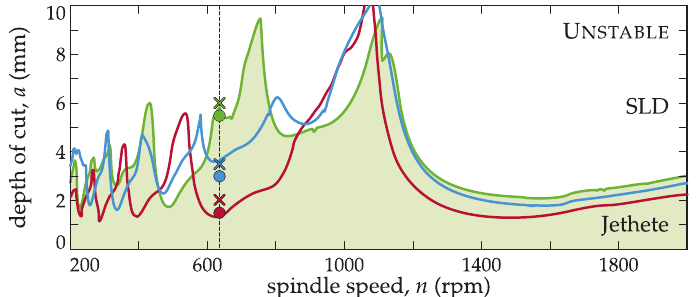
Figure 6. SLD’s and experimental tests for tuned tools (Table 3) for 636 rpm according to Figure 5a,b. The workpiece material is Jethete, restricting the cutting speed to v c = 100 m/min (green: BF, red: regular, blue: BS; circle: stable, cross: unstable